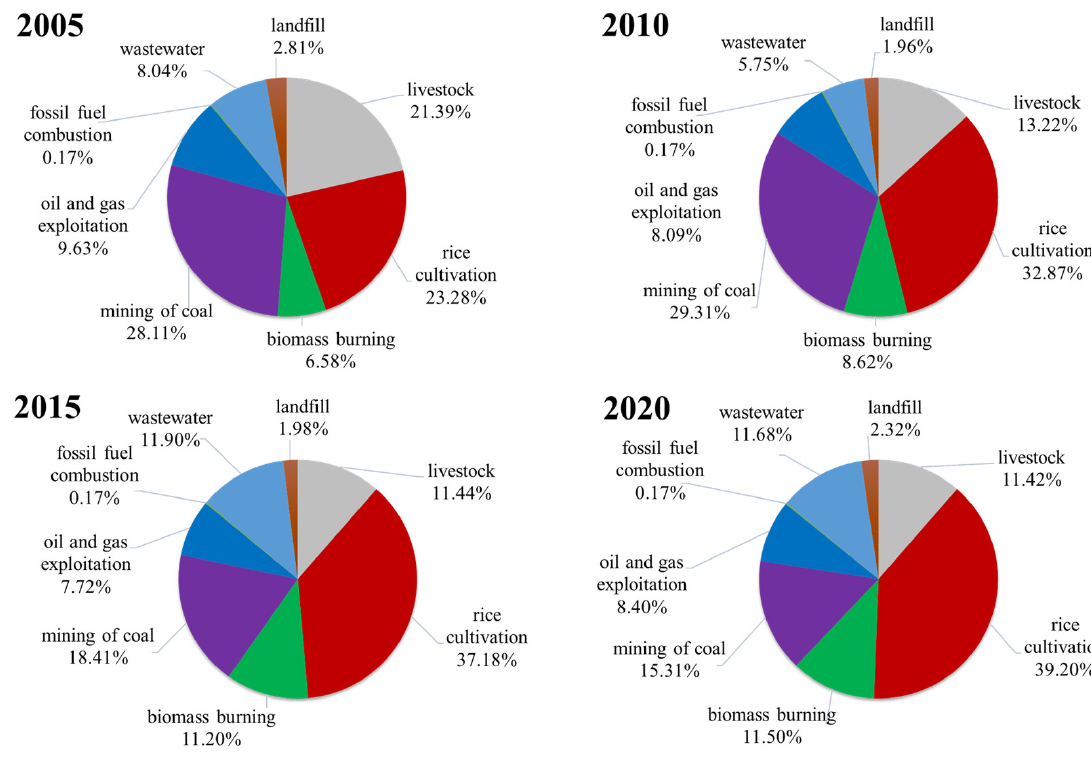
Figure 4. CH 4 emissions by sectors: contribution rates of sectors.